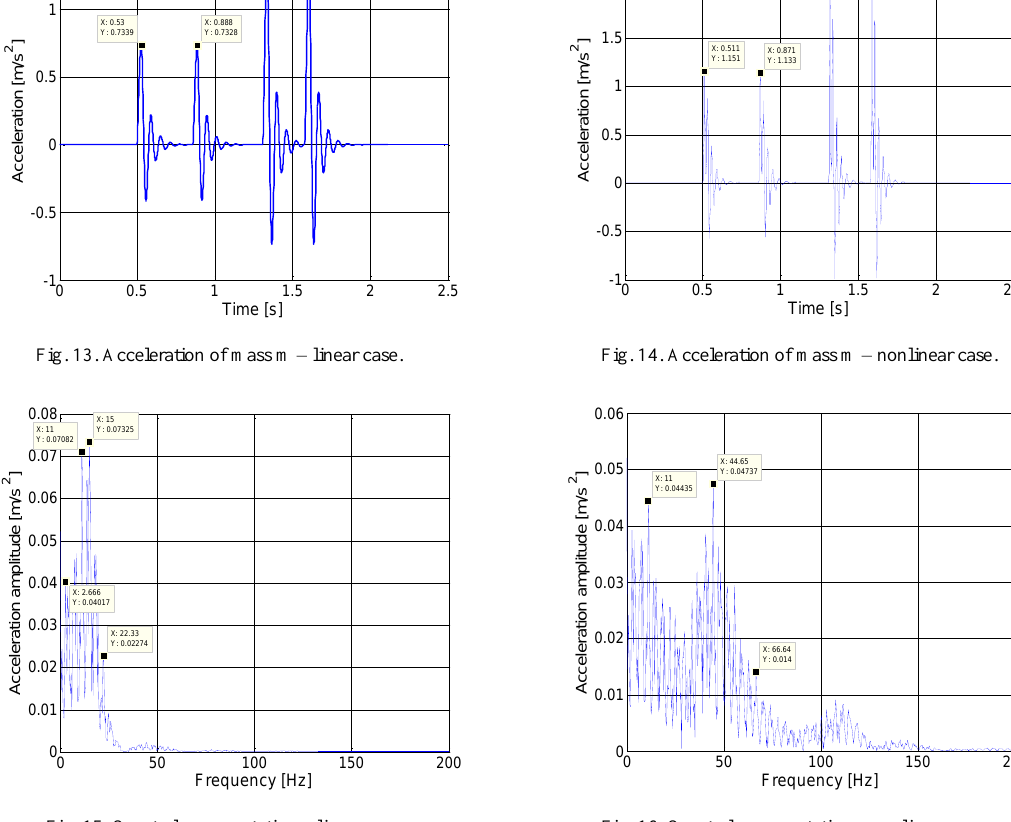
Fig. 15. Spectral representation – linear case. Fig. 16. Spectral representation – nonlinear case.